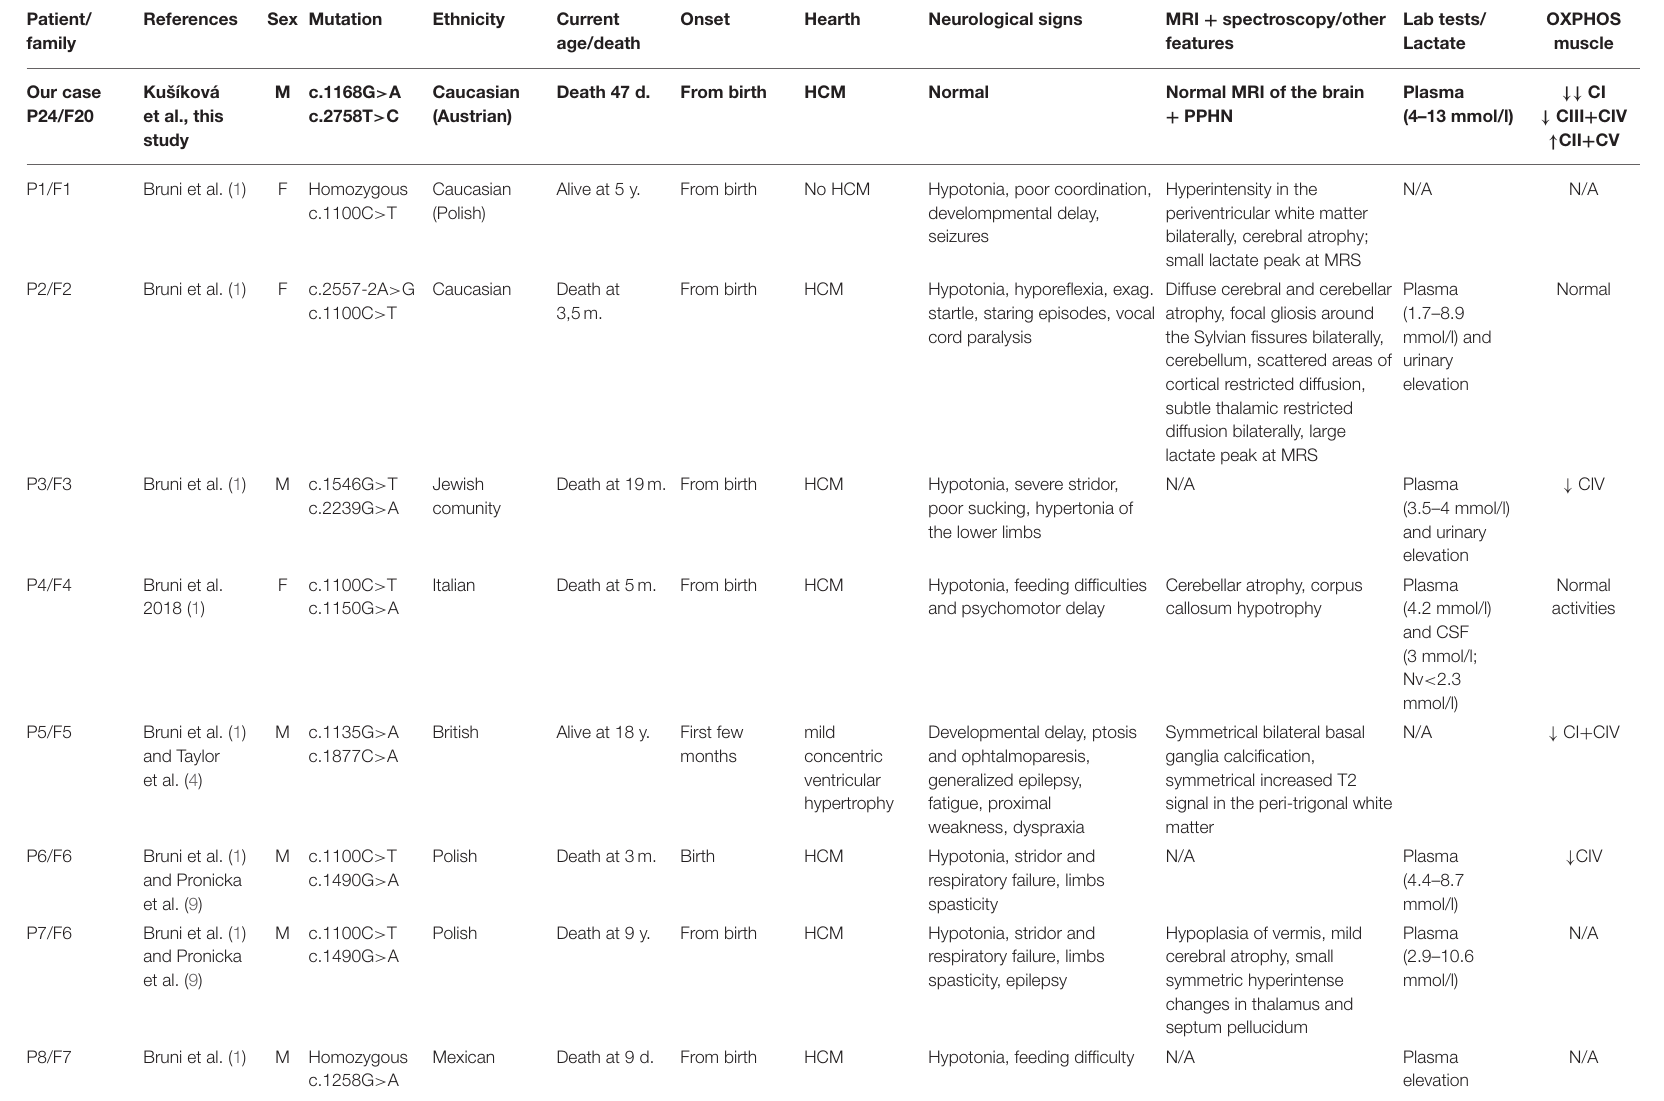
TABLE 2 | Review of published cases and new patient with VARS2 deficiency – clinical characteristics, laboratory and molecular genetics findings [modified after (1)]. Patient/